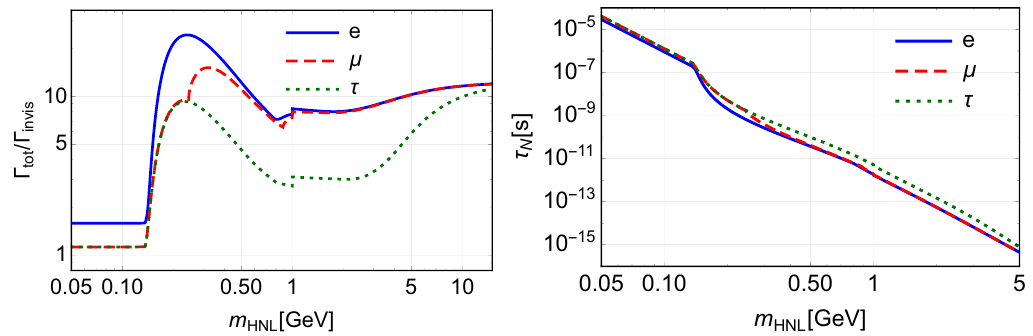
Figure 18 . HNL decay width divided by the total decay width into active neutrinos eq. (3.5) (left panel) and lifetime (right panel) as a function of HNL mass. Results are given for the pure e , (cid:22) and (cid:28) mixings, U (cid:11) =